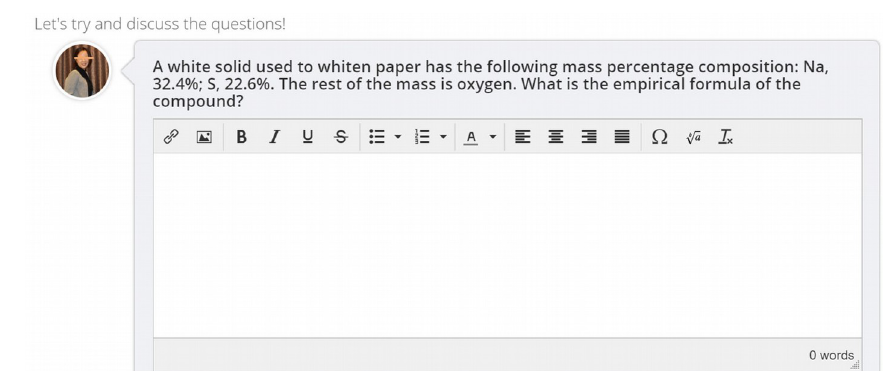
Figure 5. An example of question posted in the